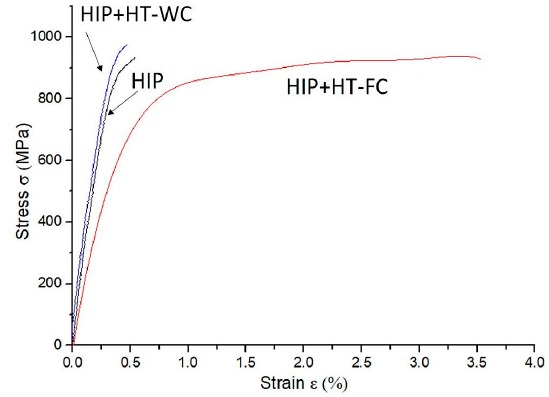
Figure 11. Tensile stress–strain curves for HIPped, HIP + HT – WC, and HIP + HT − FC samples.